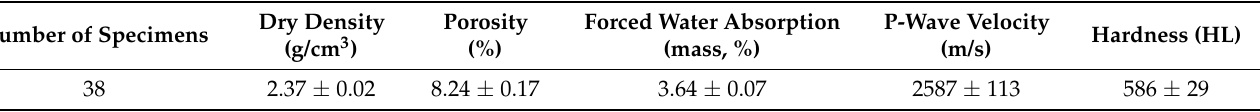
Table 3. Basic physical properties of fresh Yungang sandstone.